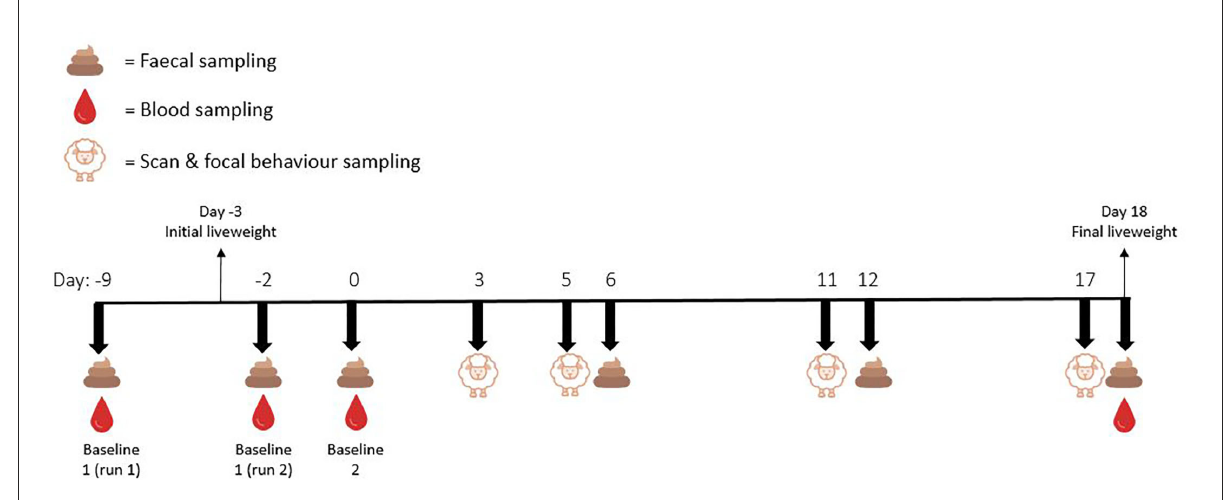
FIGURE1 Experimental timeline depicting the days on which blood, faeces, whole of pen scan sampling behaviours, and focal animal continuous behaviours were